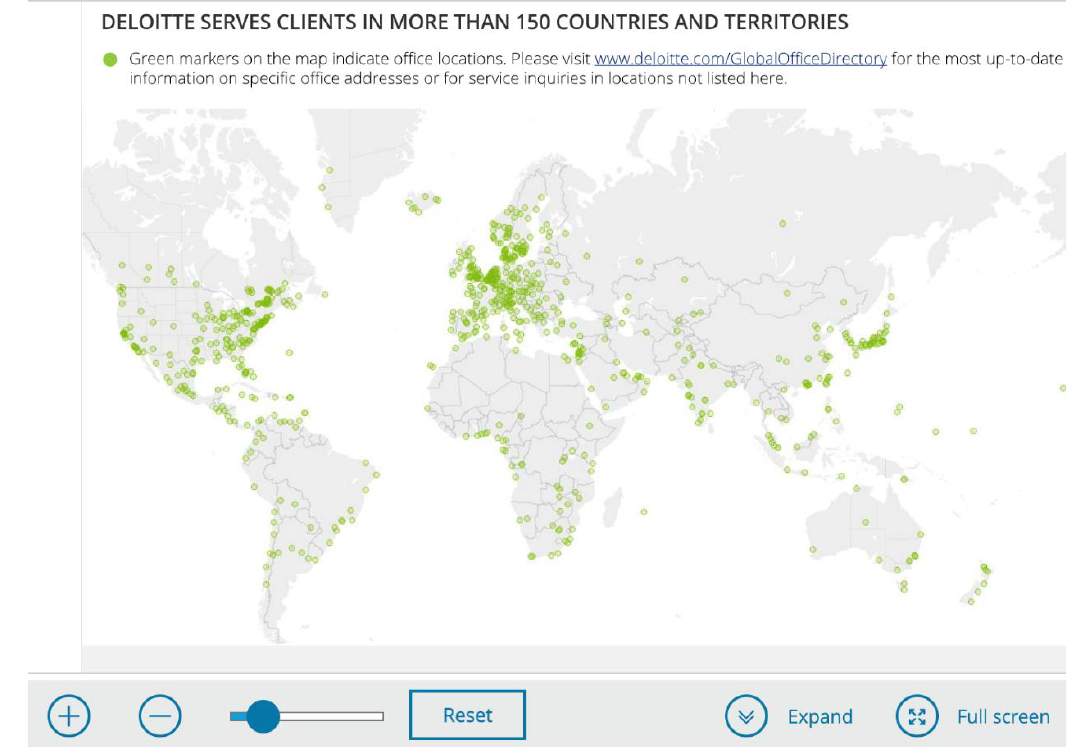
Figure 2. Website of Deloitte providing an option to select ‘location’, giving addresses of offices. Source: https://www.deloitte.com/GlobalOfficeDirectory, accessed on 20 August 2022.